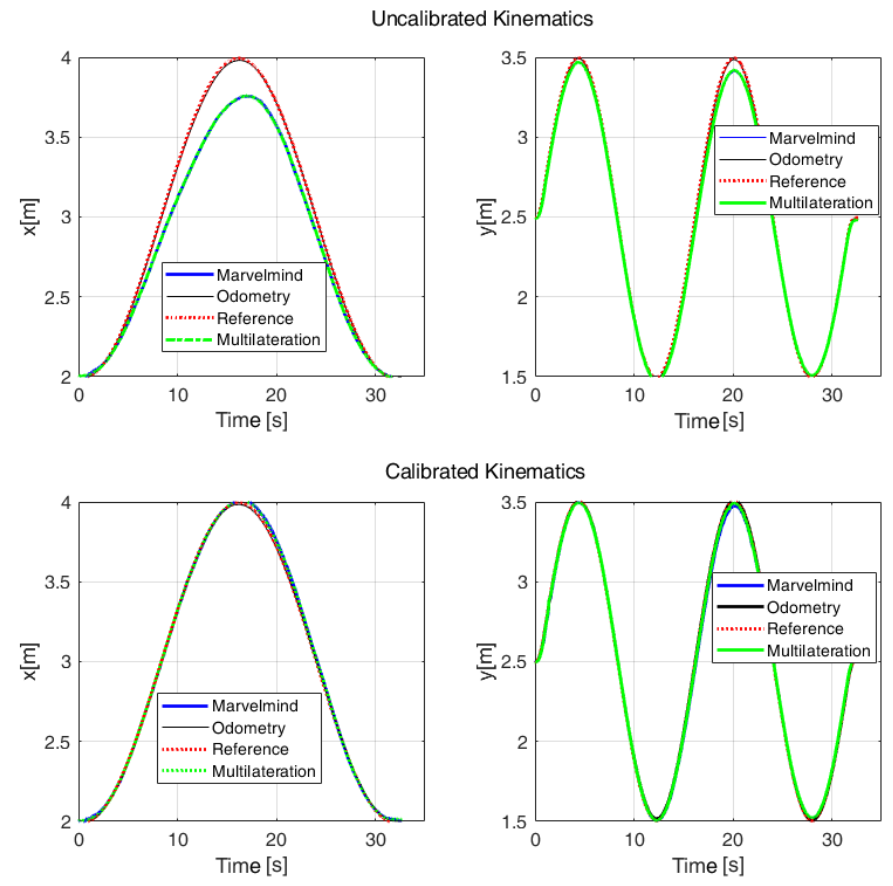
Figure 17. The comparison between the estimated and real position of the OMR on the Lissajous curve